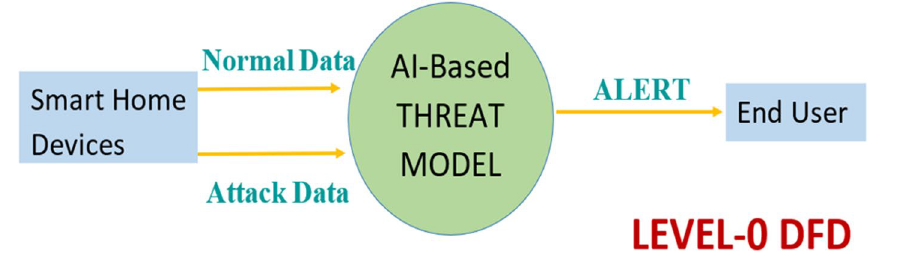
Figure 3. DFD : The level-0